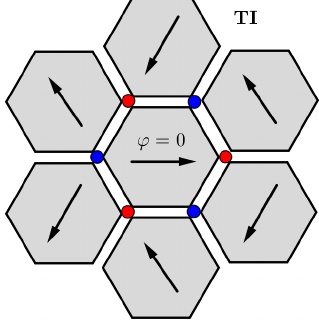
FIG. 3. Array of hexagonal s -wave superconducting islands placed on a TI surface. Each arrow points in the direction of the relative phase of the associated island, with φ ¼ 0 , (cid:2) 2 π = 3 . This produces a honeycomb lattice of vortices (blue) and antivortices (red) at trijunctions, hosting Majorana